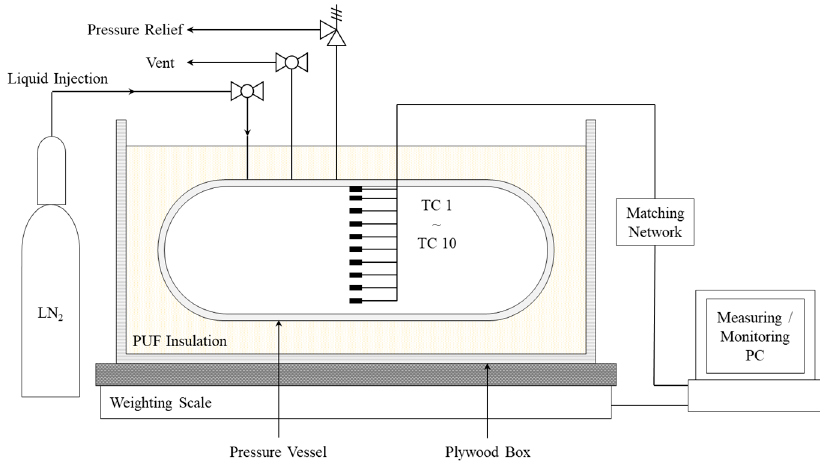
Figure 1. Schematic of experiment and arrangement for TC.